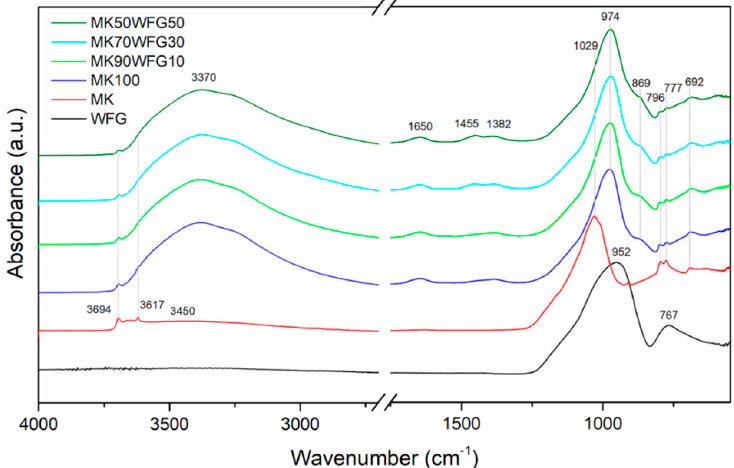
Figure 3. FTIR spectra of WFG, MK and of the produced alkali-activated materials (MK100, MK90WFG10, MK70WFG30 and MK50WFG50). The wavenumbers of the main bands are indicated.